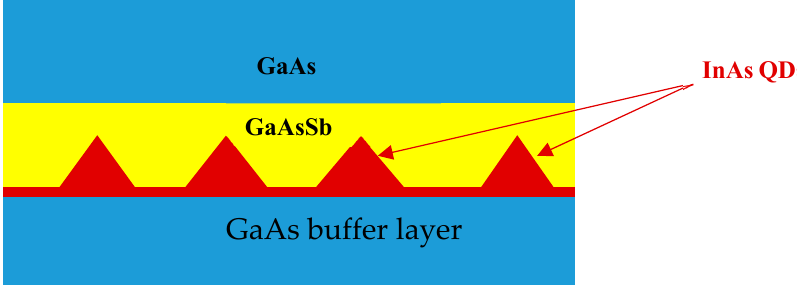
Figure 1. Schematic presentation of the GaAsSb-capped InAs QDs grown by molecular beam epitaxy.